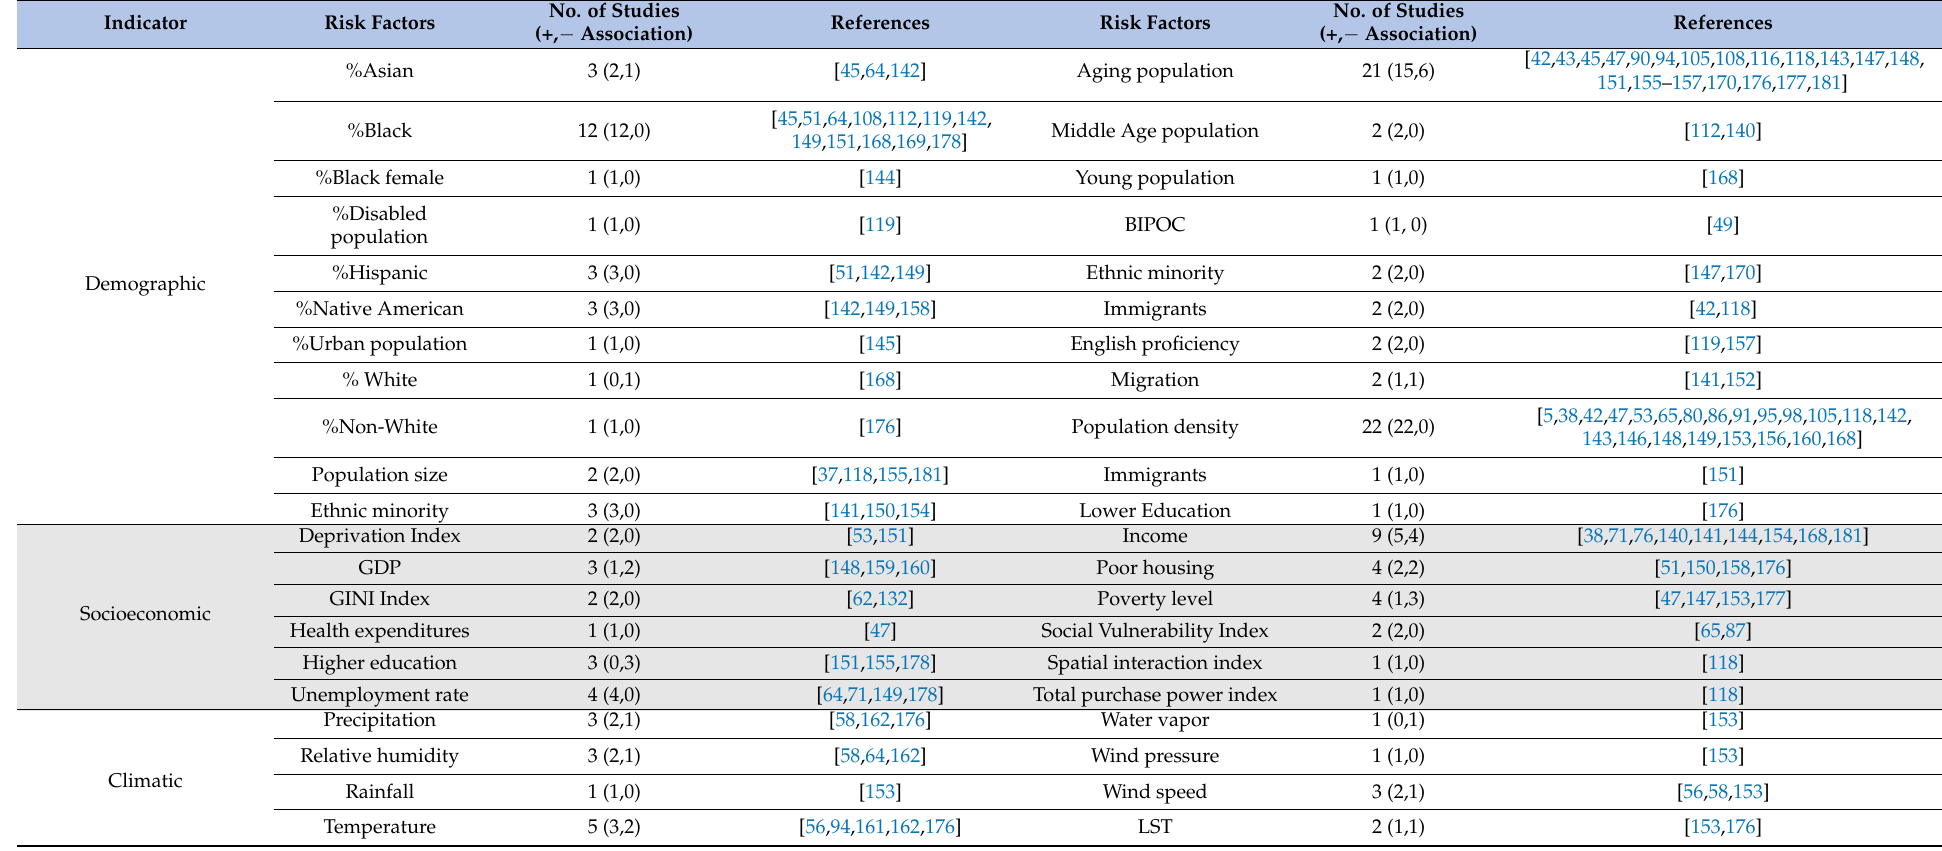
Table 3. Risk factors for spatial variations of